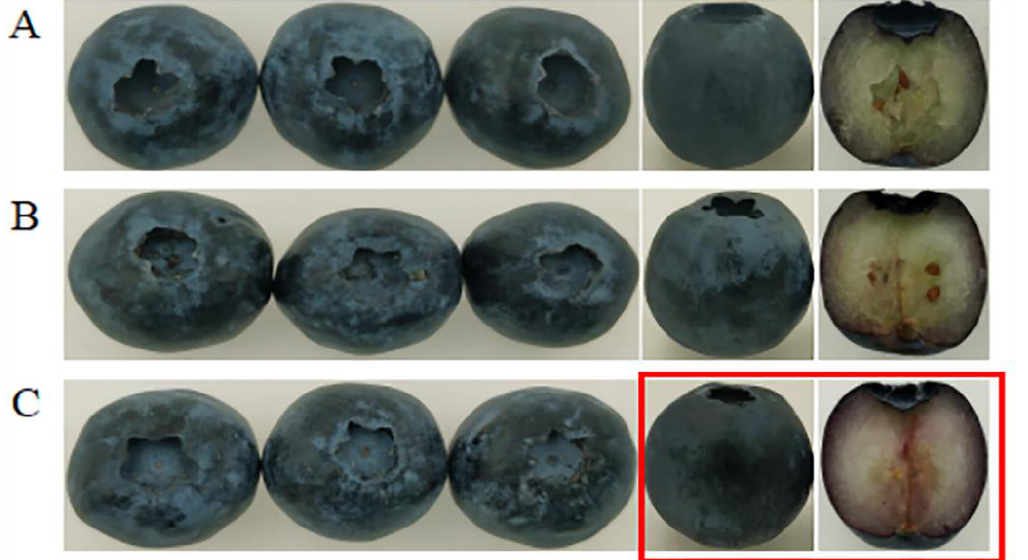
Figure 9. Effects of overexpression of VcPG1 on the morphology of blueberries at 20 °C. ( A ) Fresh blueberries (0 d). ( B ) Empty vector (20 °C, 6 d). ( C ) Overexpression of VcPG1 (20 °C, 6 d). The red frame indicates that after the overexpression of VcPG1 , the softening symptoms were enhanced.